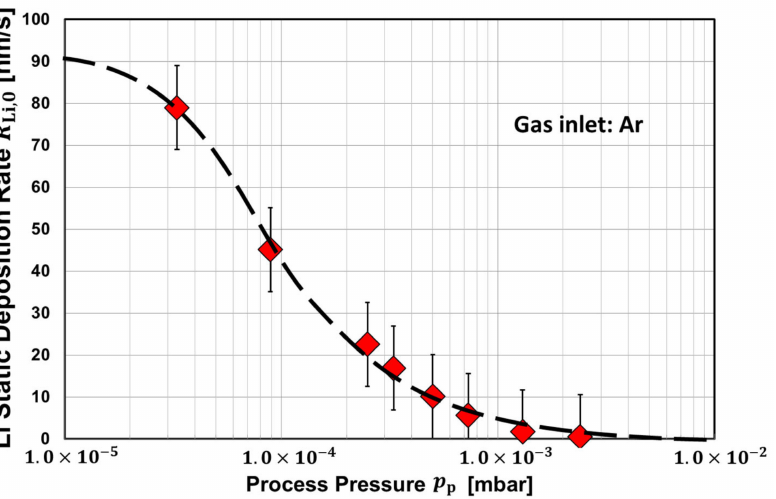
Figure 5. Li’s static deposition rate at varying process pressures. The dashed line represents the expected trend.